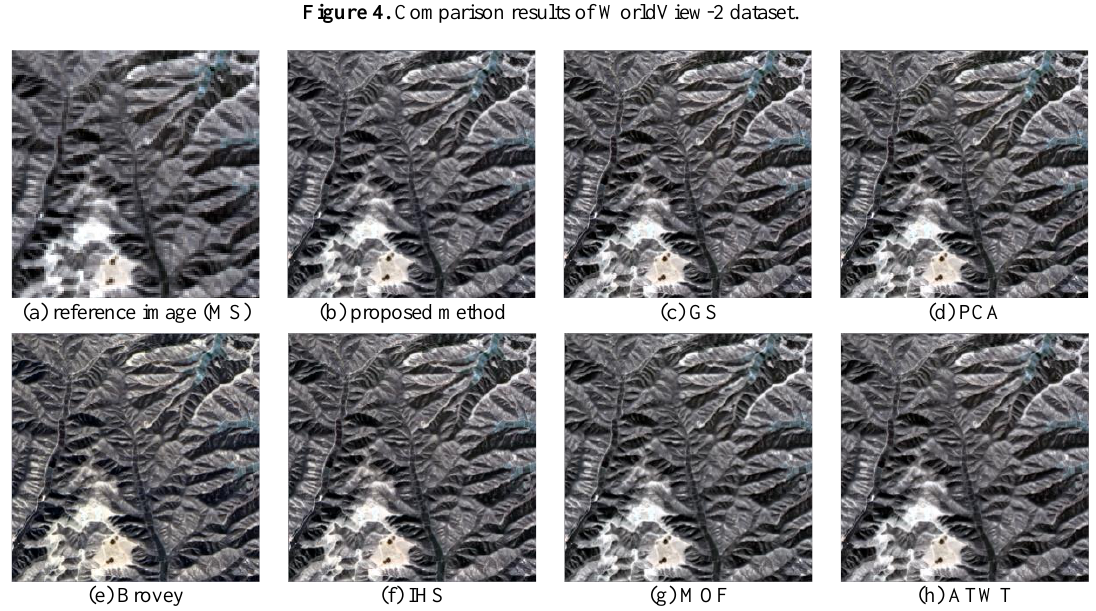
Figure 5. Comparison results of GF-2